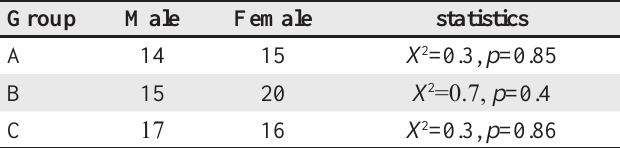
Table 1 : Gender distribution in treatment group.